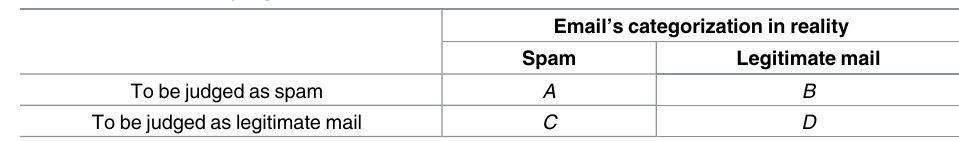
Table 2. Four cases of